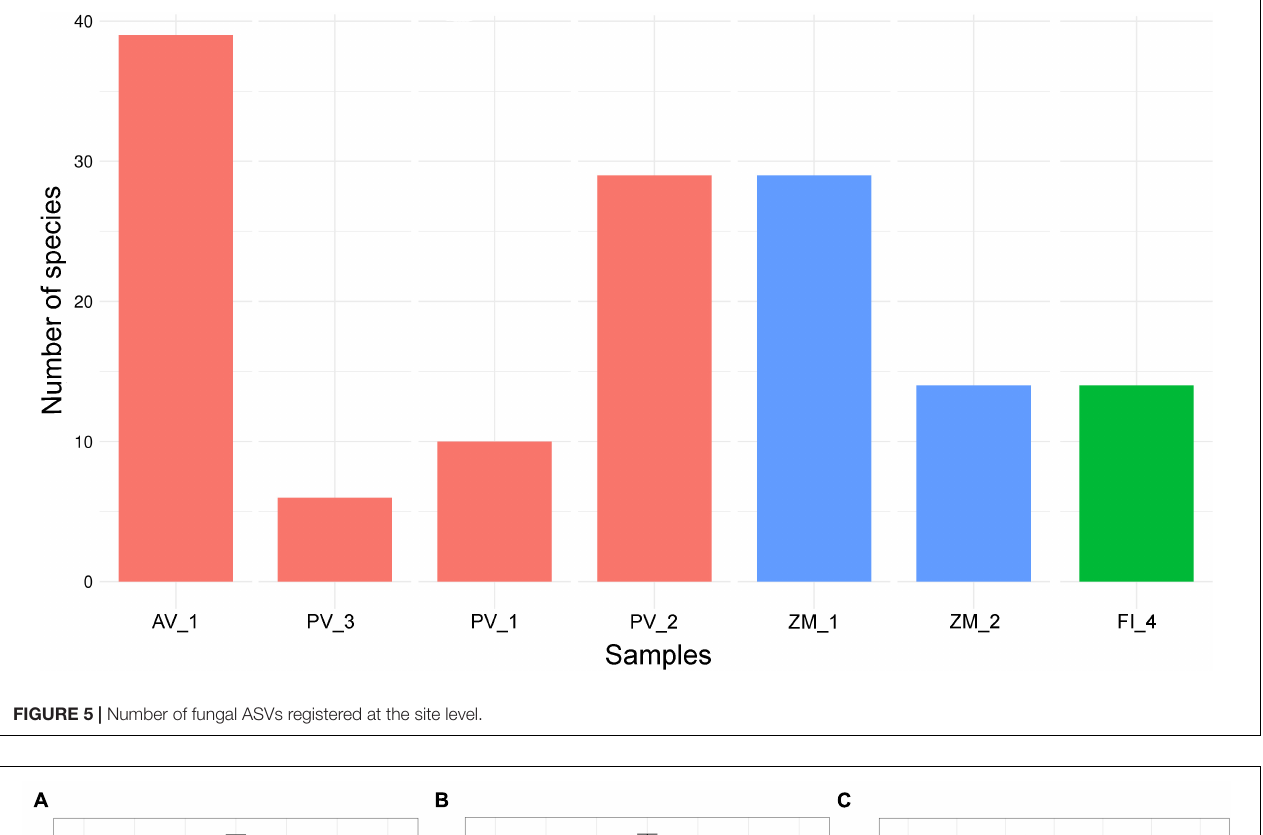
FIGURE 5 | Number of fungal ASVs registered at the site level.